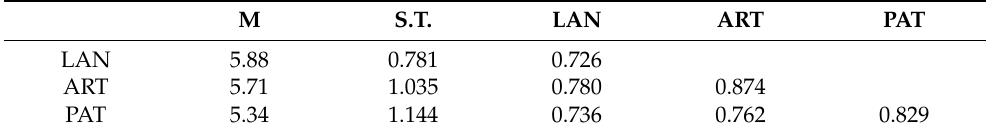
Table 4. Discriminant validity of the constructs.